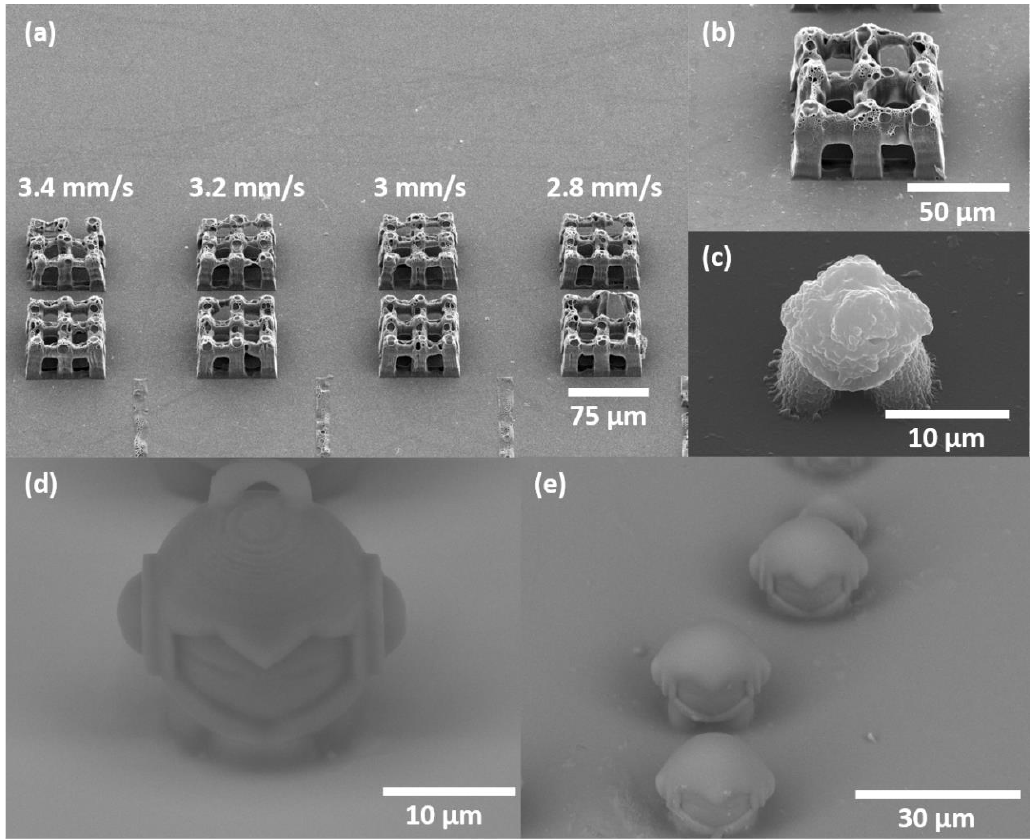
Figure 9. ( a ) Array of the 75 × 75 µ m 2 size woodpile structures out of C4 resin: v varies from 2.8 to 3.4 mm / s, P = 0.4 mW ( I = 1.2 TW / cm 2 ) and d xy = 0.25 µ m (lower row), P = 0.5 mW ( I = 1.5 TW / cm 2 ) and d xy = 0.5 µ m (upper row). ( b ) Close-up of the 75 × 75 µ m 2 woodpile structure: v = 1 mm / s, P = 0.3